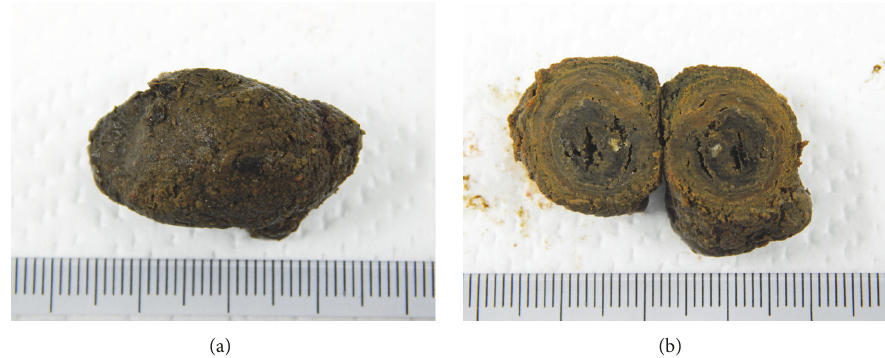
Figure 2: Photographs of the enterolith. Enterolith of 3 × 2cm in size was surgically removed (a). The cut surface shows a multilayered structure (b).